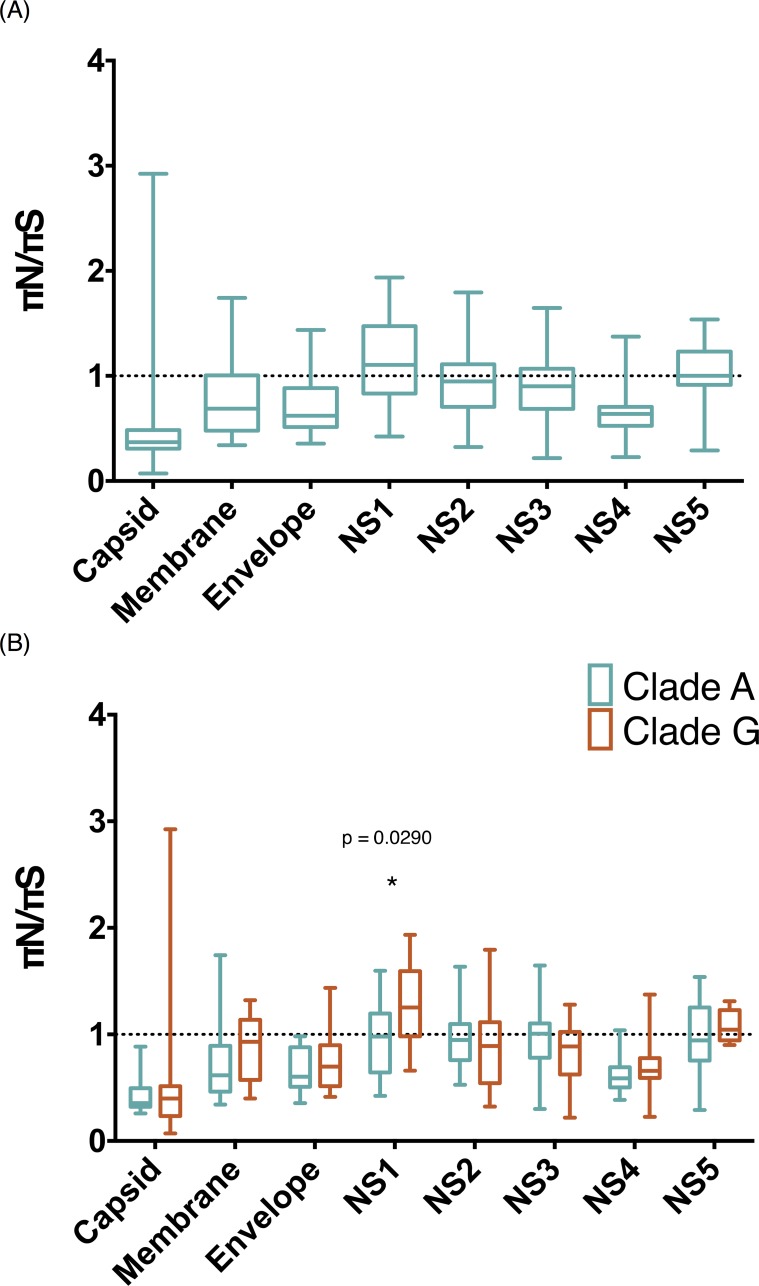
Statistically significant increase in average πN/πS ratio between clades A and G.The πN and πS statistic were calculated for each gene using assemblies subsampled to 500x coverage across the CDS for each sample. The average value for each gene across each clade is displayed as a box and whisker (min to max) plot. (A) All samples pooled into one data set. (B) Comparison between samples containing E:558Avs.G. We found a statistically significant difference in the average πN/πS ratio of the NS1 gene (P = 0.029; Student’s t-test) between groups A and G (πN/πS ratio = 0.960 and, 1.284 for clades A and G, respectively).